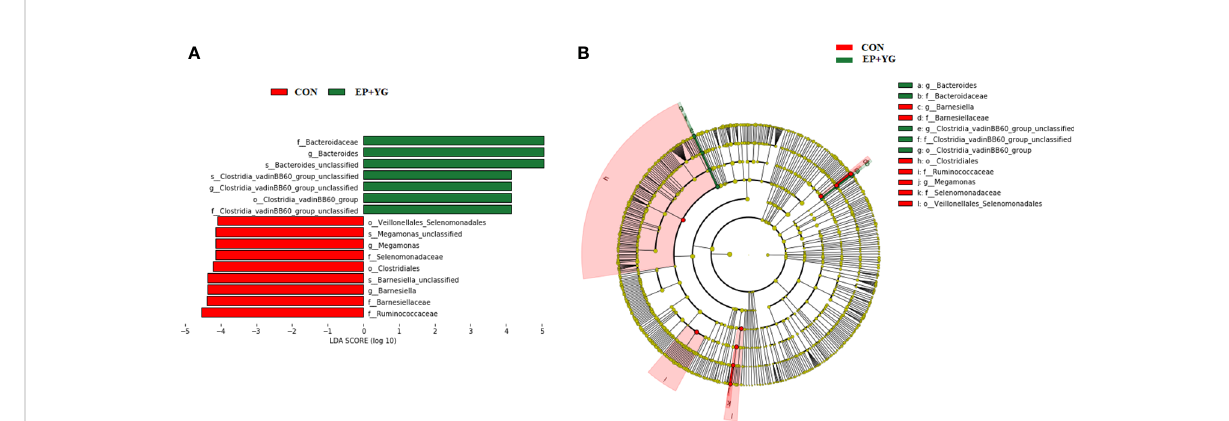
FIGURE 6 Linear discriminate analysis (LDL) effect size (LEFSe) analysis identi fi ed microbial taxa between EP+YG (green) and control (red) group. (A) Histogram plot from LEfSe analysis that presents the LDA scores of microbial taxa whose abundance showed signi fi cant differences between control and EP supplemented group broiler chickens (LDA score > 4). The length of the bar column represents the LDA score. (B) In the cladogram, circles radiating from the inner side to the outer side represent the differences in the relative abundance of taxa from phylum to genus level between EP and control groups.